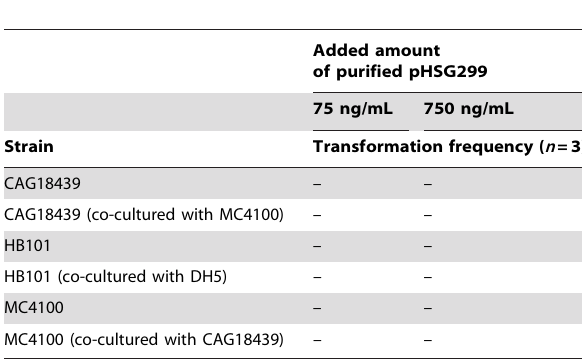
Table 6. Natural transformation with purified plasmid in liquid culture.